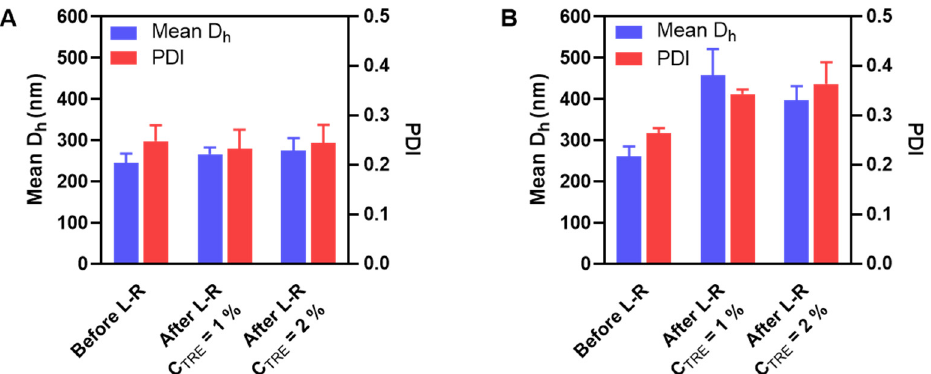
Figure 4. Mean D h and PDI before and after lyophilization and reconstitution (L-R) of HA-M2005/DEAE-D PEC-NGs ( A ) and HA-M2005/PLL PEC-NGs ( B ) at n − /n+ = 2.5 and C P = 0.5 g.L − 1 with different trehalose concentrations ( n ≥ 3). The results of freshly prepared PEC-NGs (before L-R) were retrieved from our previous work as references [4].